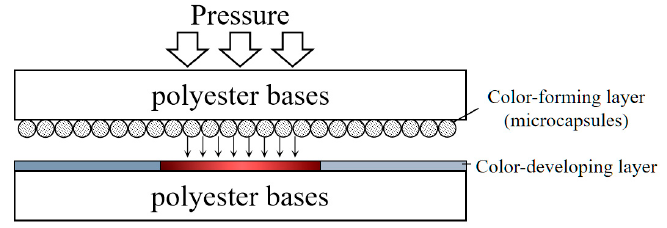
Figure 3. Pressure-sensitive film configuration.